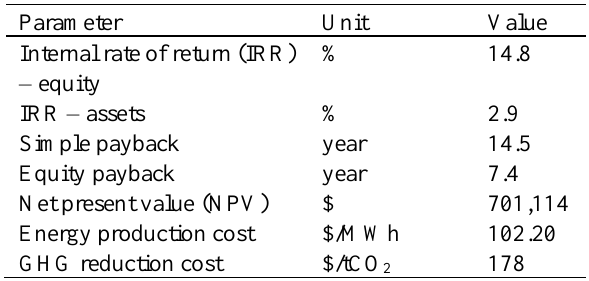
Economic analysis